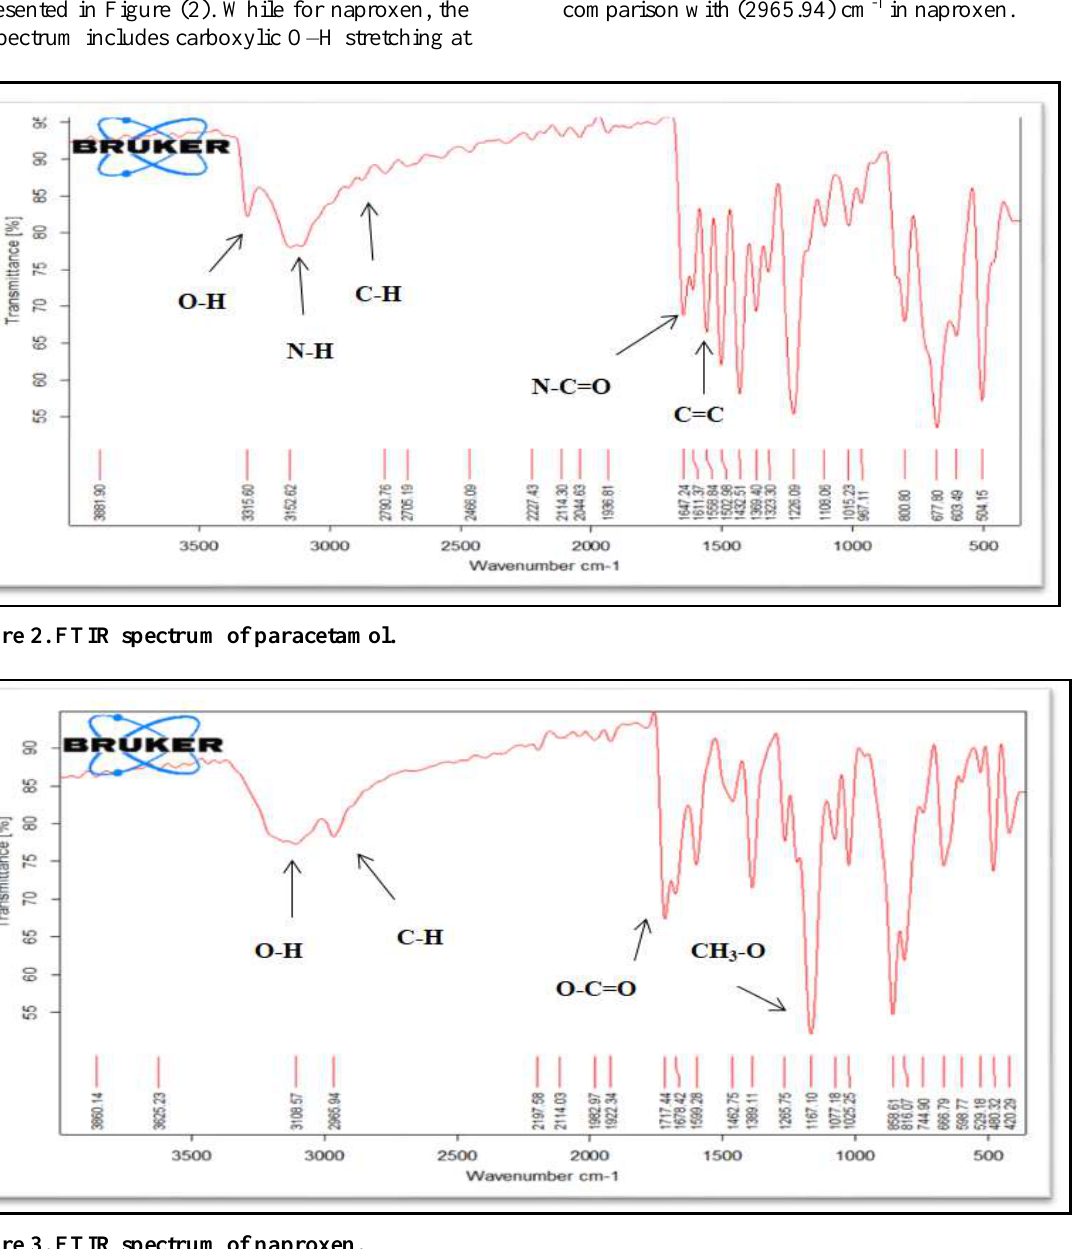
Figure 3. FTIR spectrum of